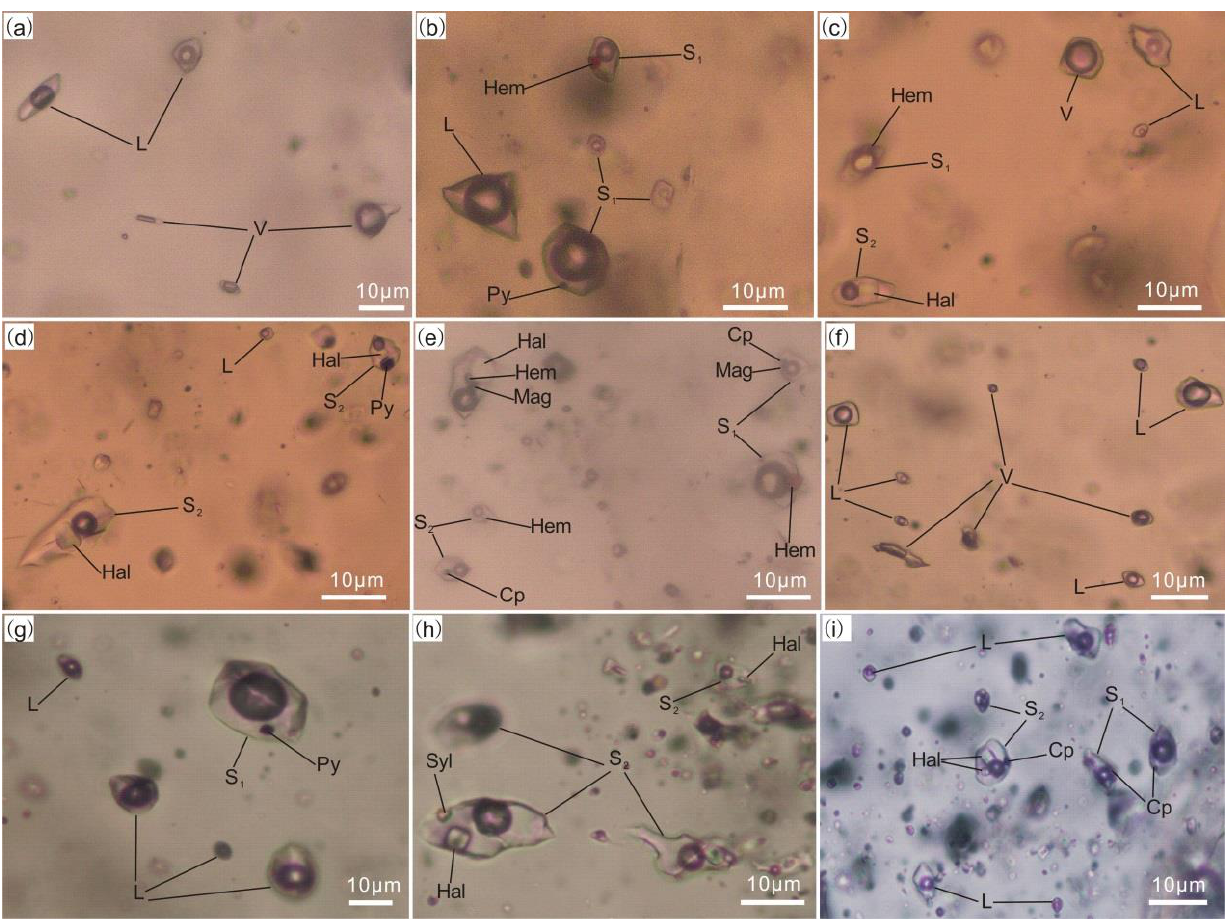
Figure 6. Typical fluid inclusions in Cu and Mo stages of the Jiama deposit (under the polarizing optical microscope). ( a ) Combination of L- and V-type inclusions in Cu-bearing vein (ZK1616-167 m); ( b ) combination of L- and S 1 -type inclusions in a Cu-bearing vein, and S 1 -type inclusions containing hematite (Hem) and pyrite (Py) (ZK1614-158.2 m); ( c ) combination of L-, V-, S 1 -, and S 2 -type inclusions in a Cu-bearing vein, and an S 1 -type inclusion containing Hem and an S 2 -type inclusion containing halite (Hal) (ZK1615-438 m); ( d ) combination of L- and S 2 -type inclusions in a Cu-bearing vein, and an S 2 -type inclusion containing Hal and Py (ZK1615-219 m); ( e ) combination of L-, V-, S 1 -, and S 2 -type inclusions in a Cu-bearing vein, and an S 1 -type inclusion containing irregular chalcopyrite (Cp), magnetite (Mag), and red Hem, while an S 2 -type inclusion contains cubic transparent Hal and red Hem (ZK1617-133.9 m); ( f ) combination of L- and V-type inclusions in a Mo-bearing vein (ZK1616-167 m); ( g ) combination of L- and S 1 -type inclusions in a Mo-bearing vein (ZK1616-404 m); ( h ) combination of L- and S 2 -type inclusions in a Mo-bearing vein, and an S 2 -type inclusion containing irregular sylvite (Syl) and cubic Hal (ZK1615-364.8 m); ( i ) combination of L-, S 1 -, and S 2 -type inclusions in a Mo-bearing vein, an S 1 -type inclusion containing Cp, and an S 2 type inclusion containing transparent Hal and Cp (ZK1616-742.8 m). The V-type inclusions are two-phase vapor–liquid inclusions at room temperature, with 60–80% vapor. The inclusions are 5–35 µ m in size and mostly irregular, spindle-like, and rectangular (Figure 6c,f). The temperature at which V-type inclusions convert to homogeneous as vapor upon heating in Cu stage and Mo stage is 328 ◦ –415 ◦ (Table